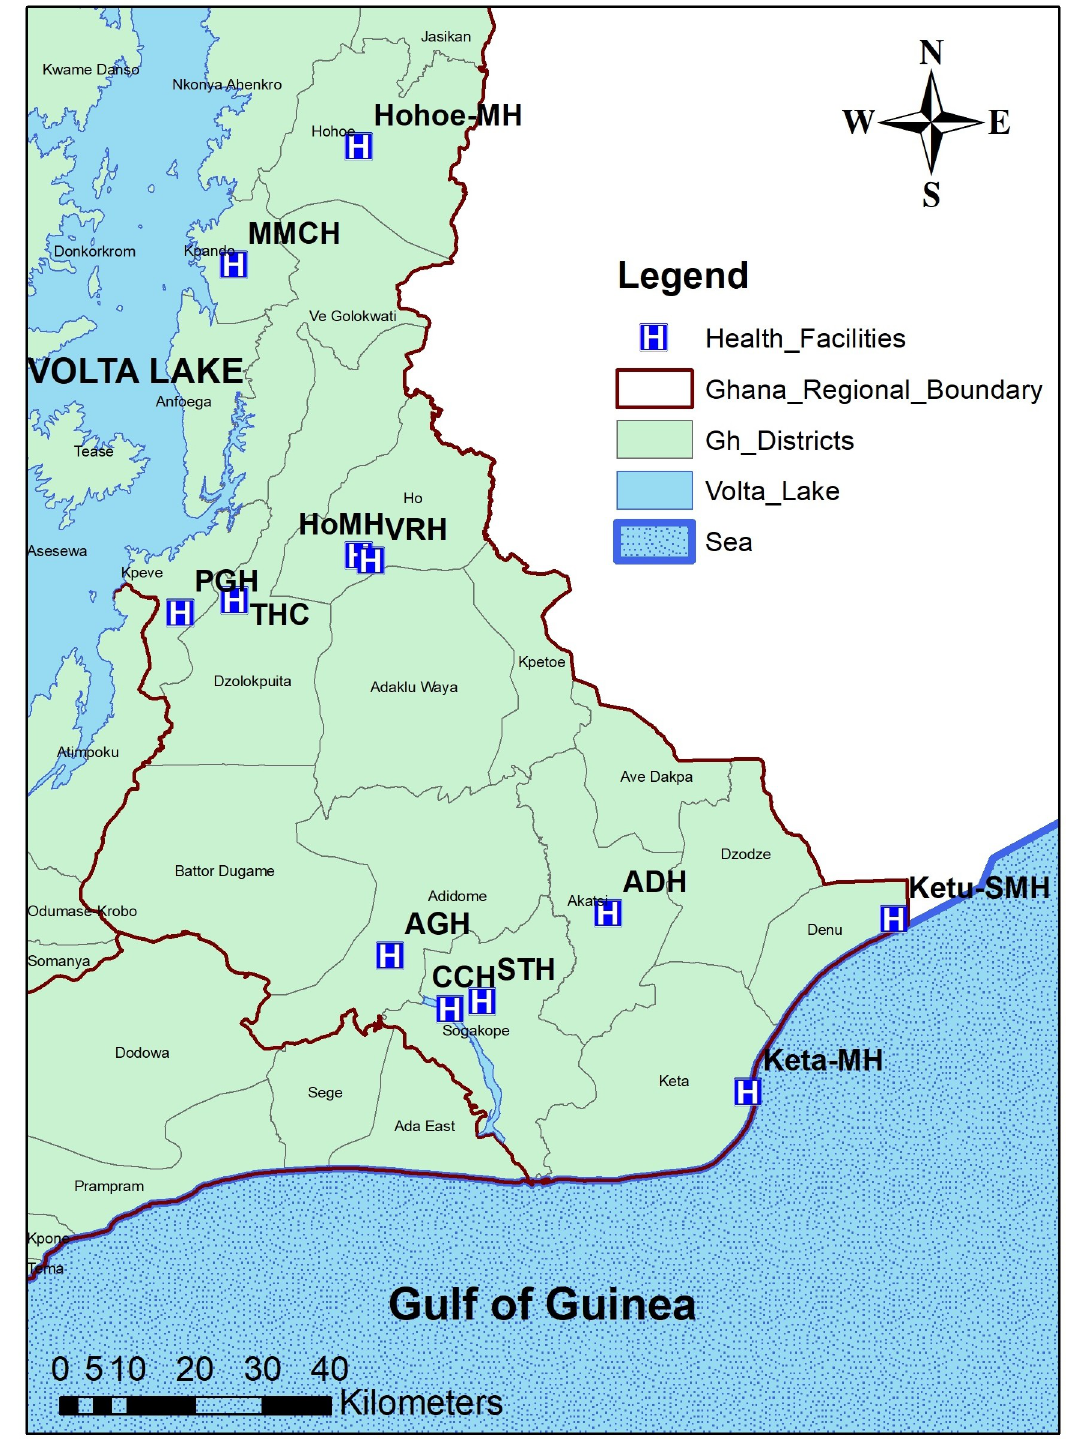
Fig 1. Study location and 12 health facilities selected. ADH: Akatsi District Hospital, AGH: Adidome Government Hospital, CCH: Comboni Catholic Hospital, HoMH: Ho Municipal Hospital, Hohoe-MH: Hohoe Municipal Hospital, Keta-MH: Keta Municipal Hospital, Ketu-SMH: Ketu South Municipal Hospital, MMCH: Margret Marquardt Catholic Hospital, VRH: Volta Regional Hospital, STH: South Tongu Hospital, THC: Tsito Health Center, PGH: Peki Government Hospital.